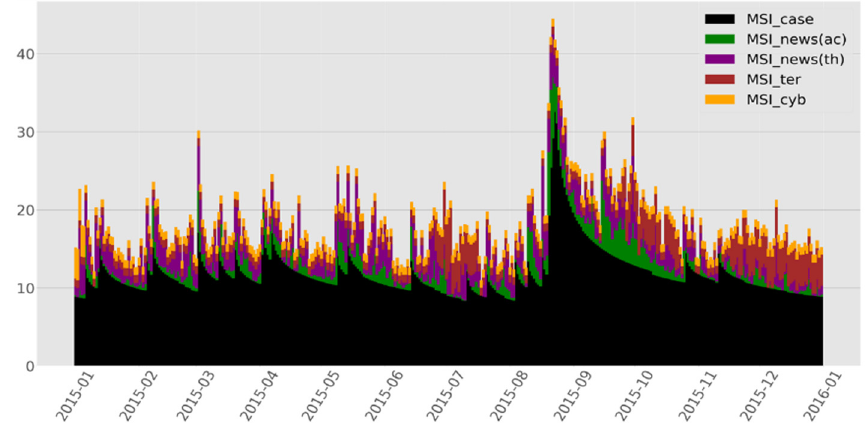
Figure 7. Military Security Index (’15).